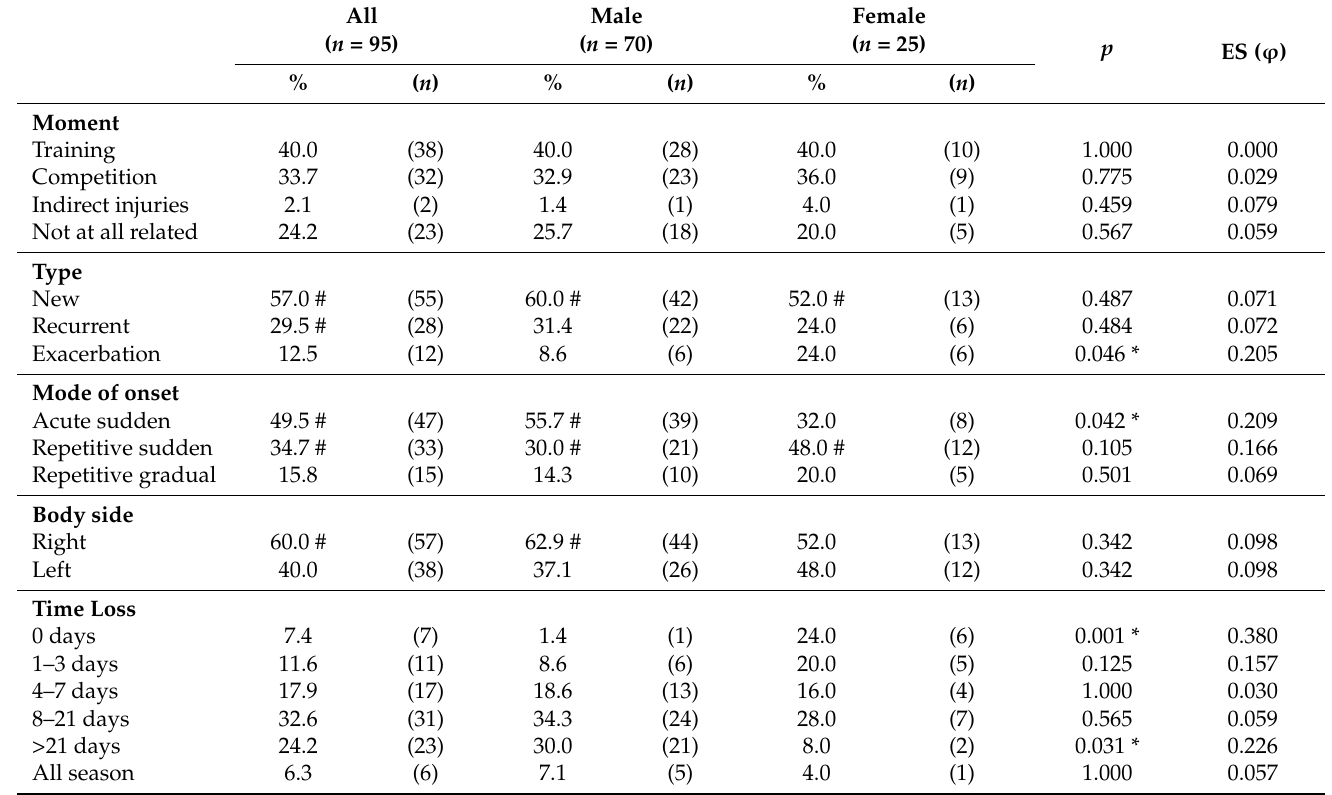
Table 2. Characteristics of injuries in male and female trail